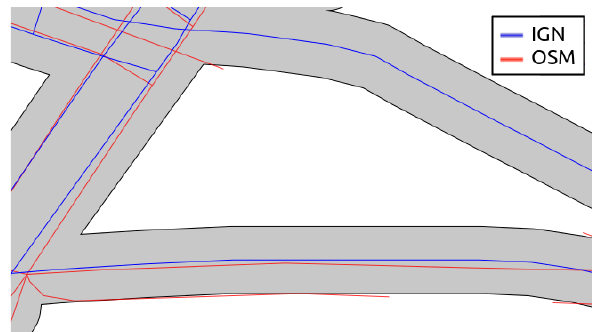
Figure 4. Detail of an area where the maximum deviation of the OSM dataset from the IGN dataset is caused by portions of OSM roads having no correspondence in the IGN dataset (data: